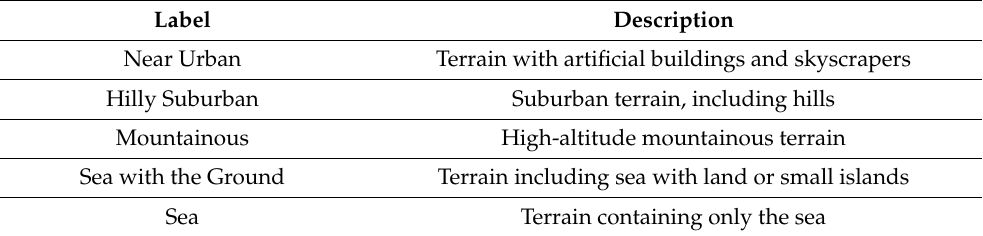
Table 2. Topography classes in South